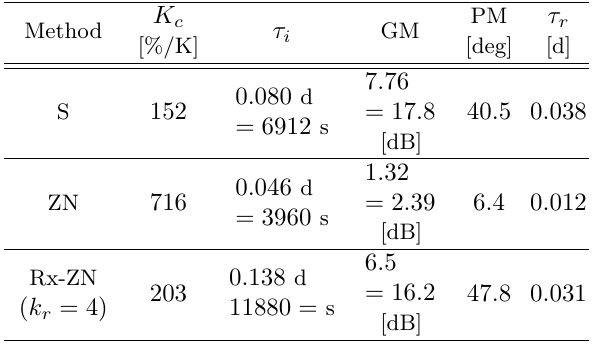
Table 1: Results with various PI tuning methods for simulated temperature control system: S = Skogestad. ZN = Ziegler-Nichols. R-ZN = Relaxed Ziegler-Nichols.